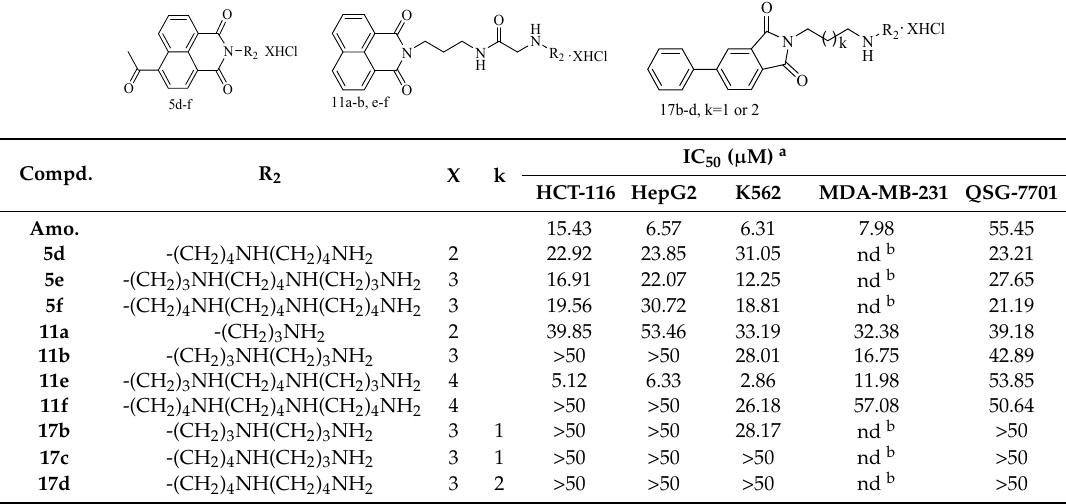
Molecules 2016 , 21 , 1637 Table 1. In vitro activity of new compounds against five kinds of tumor cell lines. O ON R 2